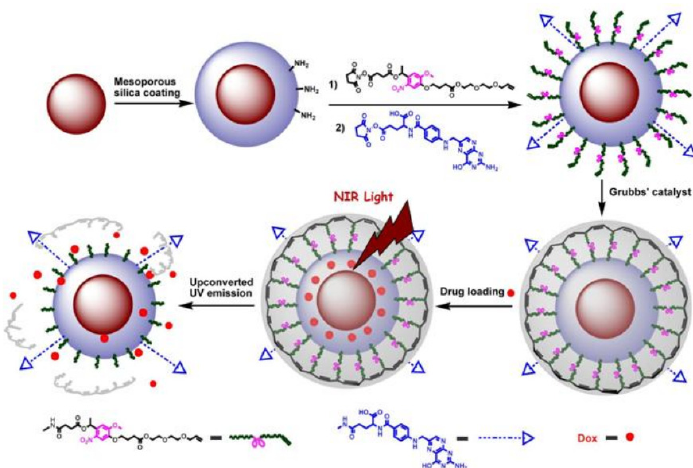
Figure 7. The design for photo-controlled Dox delivery through mesoporous silica coated UCNPs conjugated with folic acid. Adapted with permission from reference